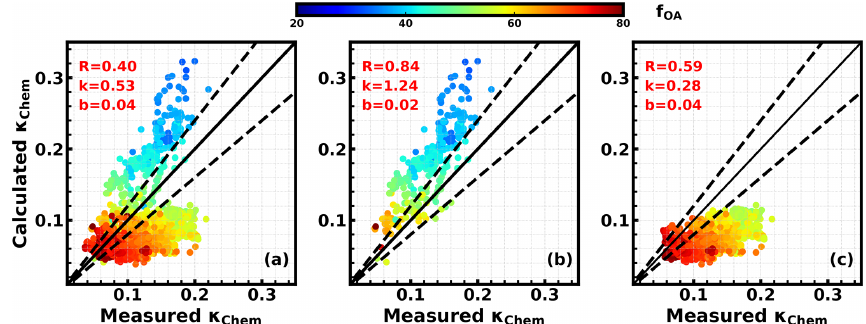
Figure 6. Comparison between measured and calculated κ chem by assuming a κ OA of 0.06. (a) The whole period. (b) Only Period 1. (c) Only Period 2. Colors represents the mass fractions of organic aerosol in NR-PM 1 ( f OA ), and the color bar is shown on the top.